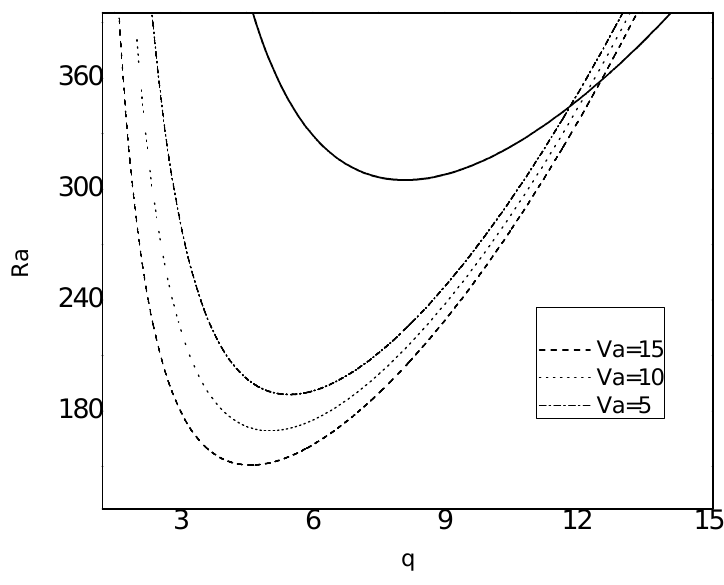
Figure 7. Neutral curves (solid lines represent the stationary convection and dotted lines represent the oscillatory convection) for Dm = 20, Ha = 0.5, Ta = 10.